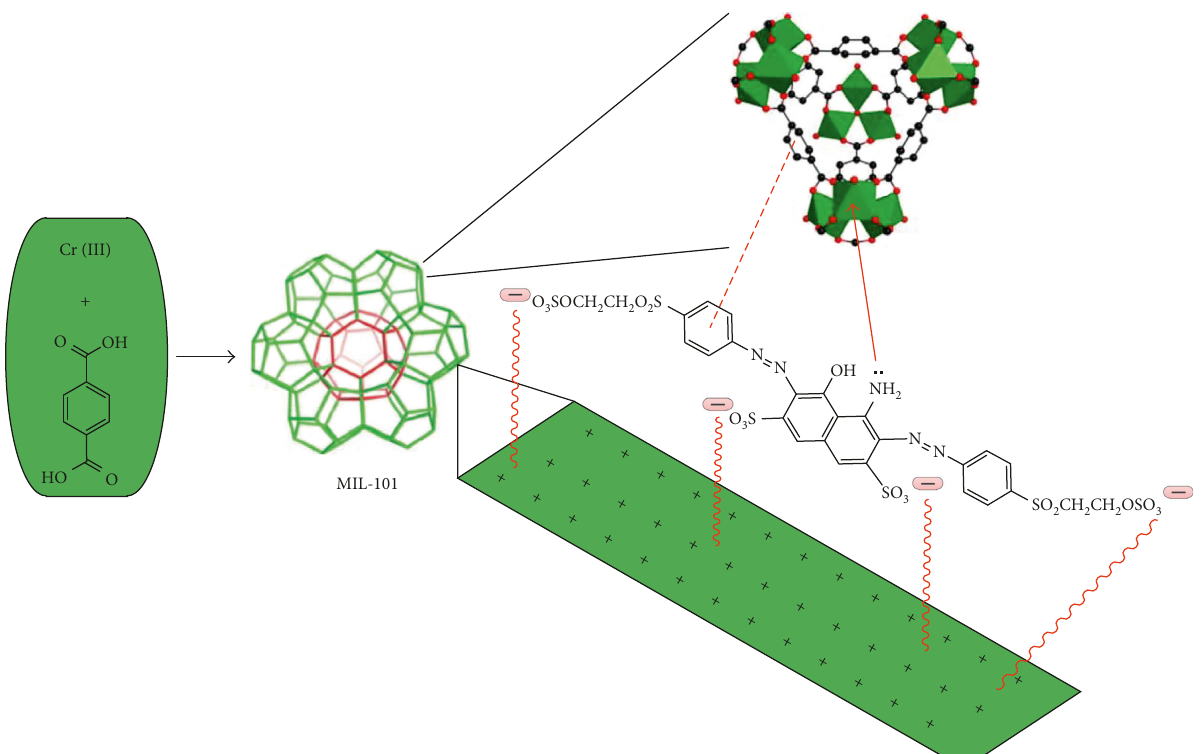
Scheme 2: Proposed mechanisms of RDB adsorption on